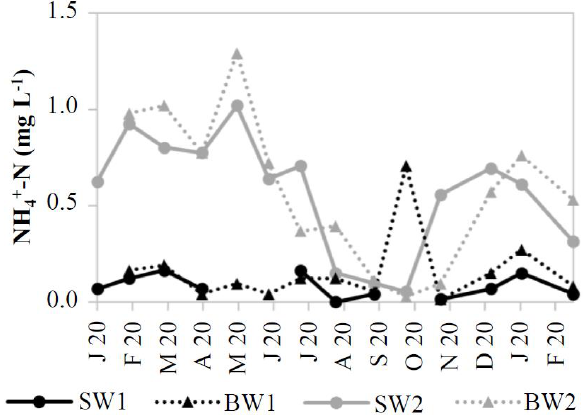
Figure 6. Concentrations of NH 4+ -N in water samples over the course of the year. SW1: surface water at P1highWT; SW2: surface water at P2lowWT; BW1: bog water at P1highWT; BW2: bog water at P2lowWT.